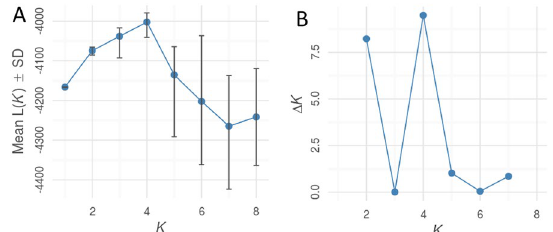
Fig. 9 STRU CTU RE HARVESTER results for Plantago maxima populations. A Mean of lnK probability and B delta K